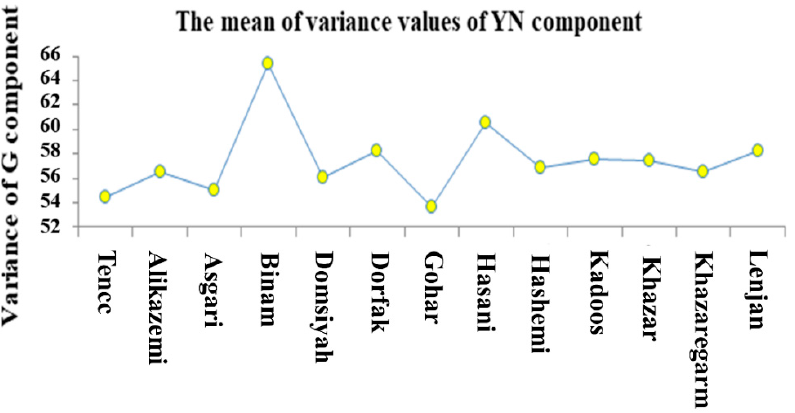
Figure 7. The mean-variance values of YN component for 13 white rice cultivars.